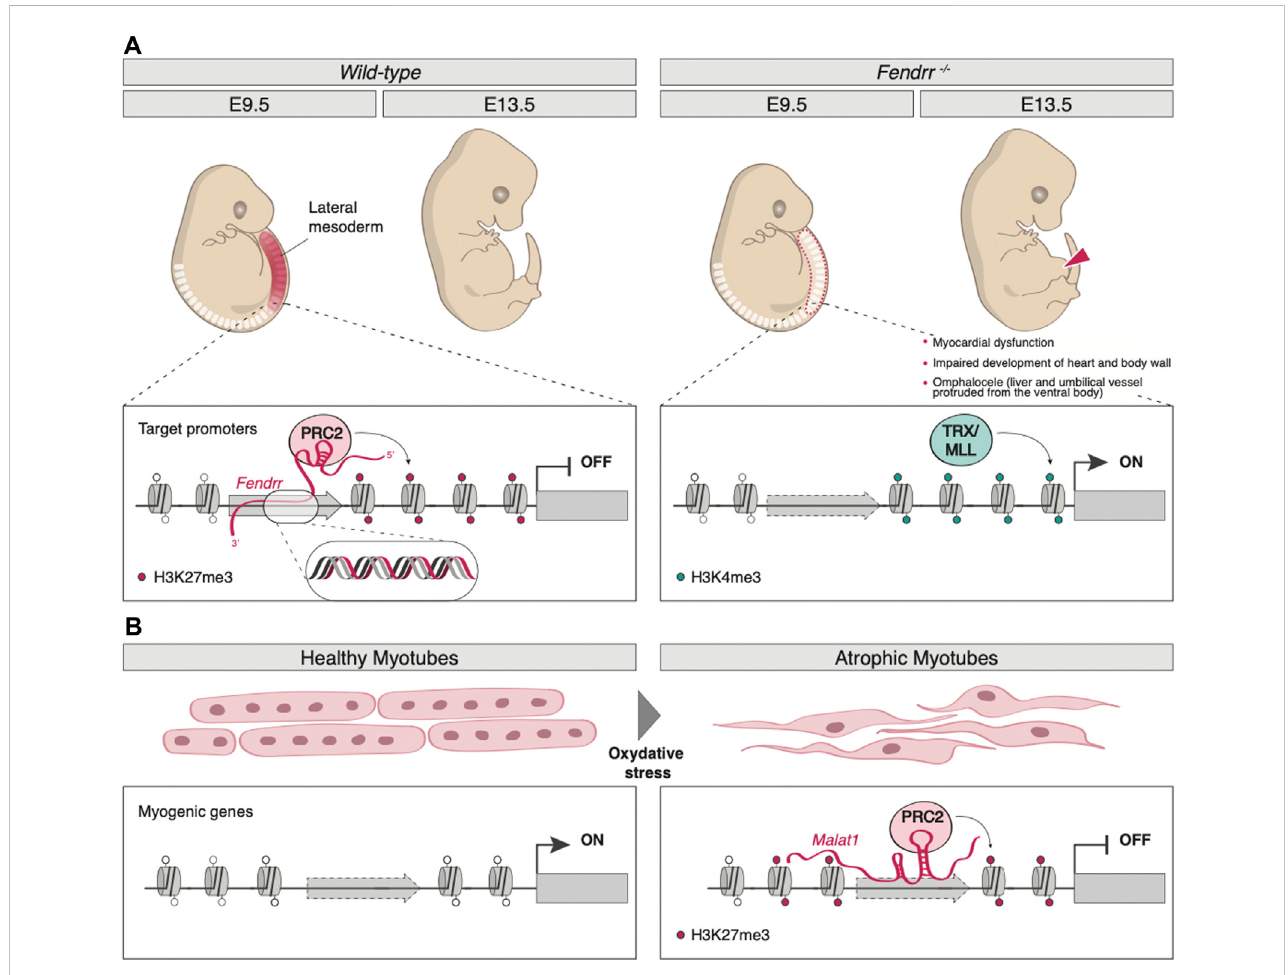
FIGURE 1 Examples of lncRNA-mediated epigeneticregulation of gene expression. (A) Byforming an RNA-DNAtriplex structure on target promoters ( Foxf1 , Pitx2, and Irx3 ), lncRNA Fendrr acts as a scaffold that promotes the binding of PRC2-inducing H3K27me3 deposition (left panel). Fendrr loss of function results in decreased PRC2 occupancy and increased TRX/MLL-mediated deposition of H3K4me3. The resulting altered epigenetic pro fi le is responsible for severe impairment in heart and body wall development and, ultimately, in embryonic lethality around E13.75 (right panel). (B) In muscle, upon oxidative stress, MALAT1 promotes PRC2 assembly and guides it on the late myogenic genes, inducing their silencing by H3K27me3